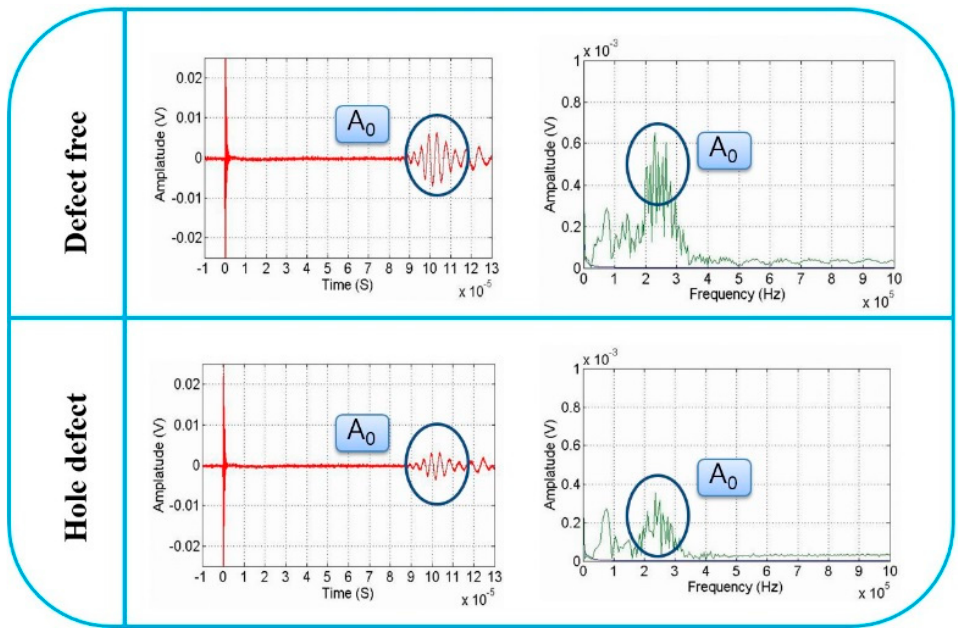
Figure 21. The signals of the defect detecting experiment.